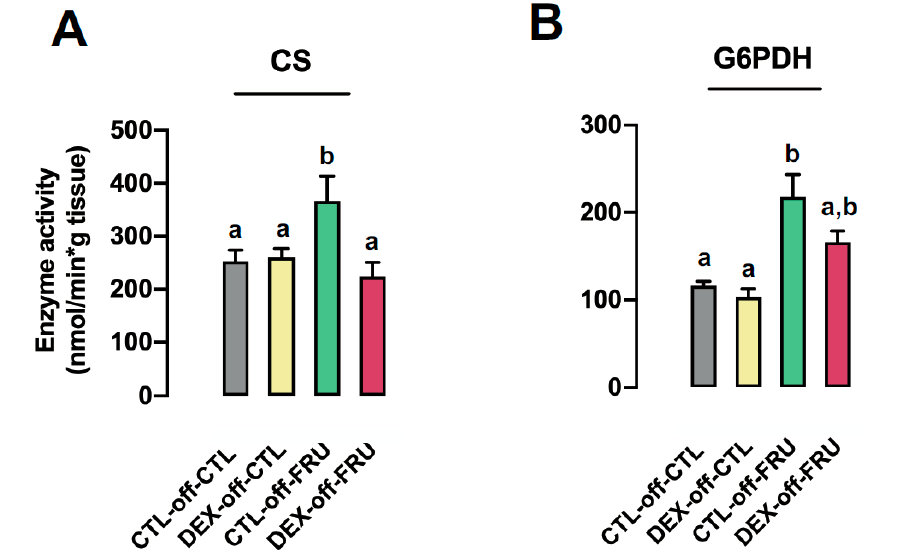
93% ( p = 0.04) and 81% ( p < 0.0003), respectively. Subsequently, subgroup analyses revealed that these